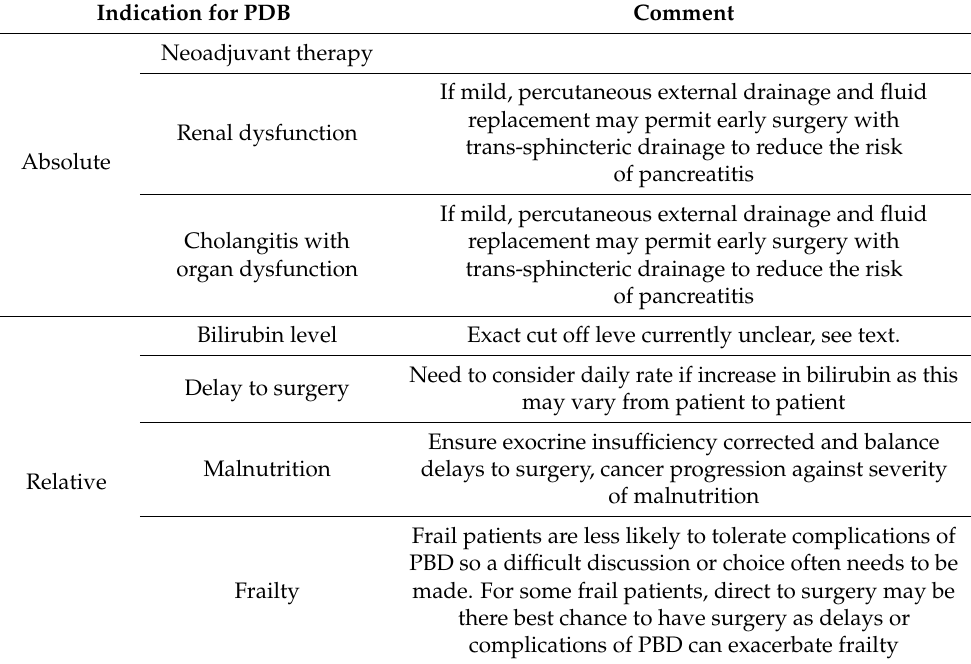
Table 1. Absolute and relative indications for Percutaneous biliary drainage (PBD).